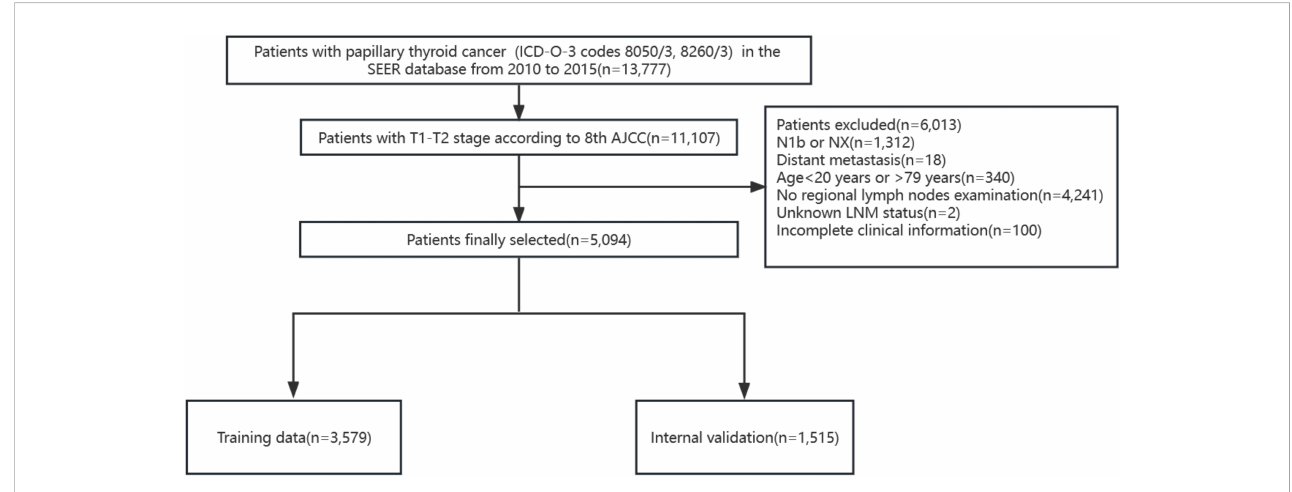
FIGURE 1 Flowchart of patient selection in SEER database. AJCC, American Joint Committee on